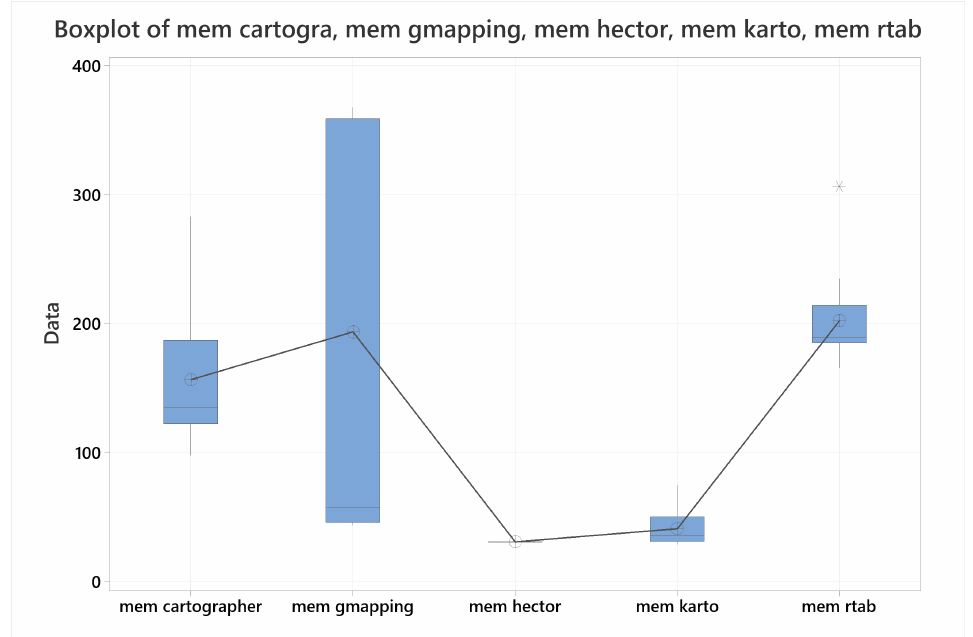
Figure 33. Boxplot for Memory usage with all the algorithms